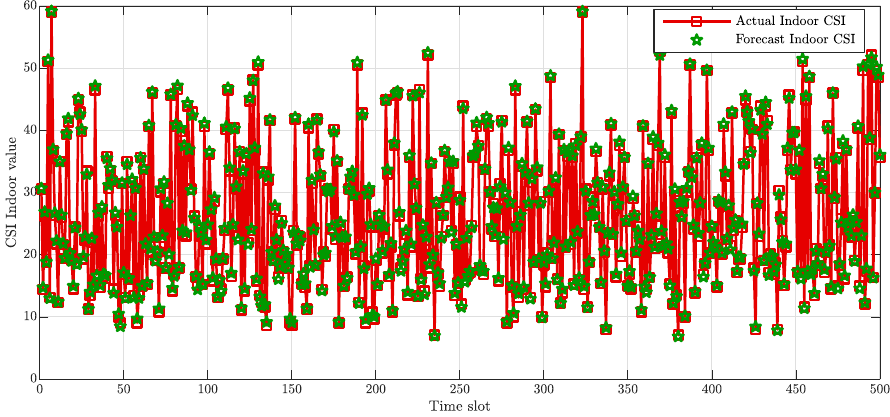
Figure 3. Indoor channel state information (CSI) amplitude value comparison in dB.